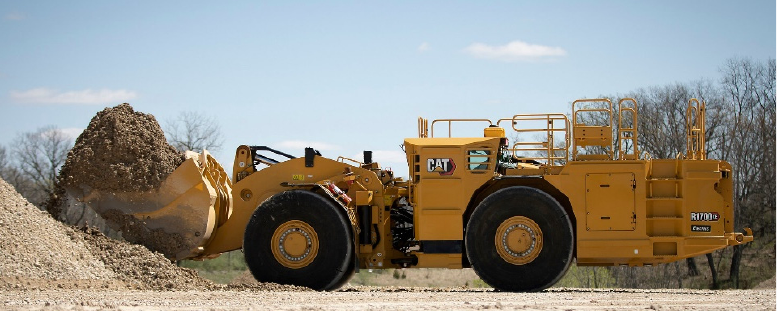
Figure 3. Caterpillar R1700 XE LHD which uses battery-powered electric motors for propulsion ([44]).